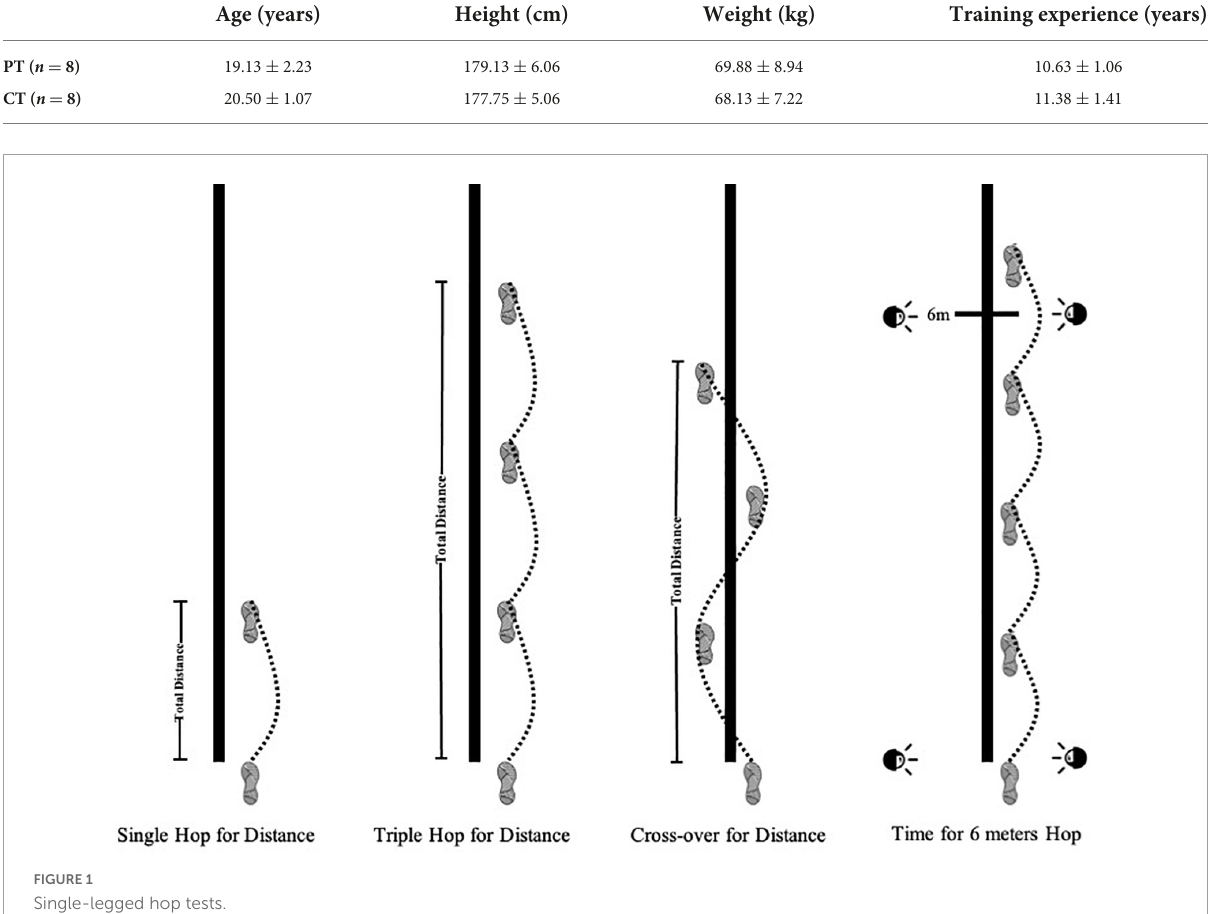
TABLE 1 The descriptive characteristics of the participants.